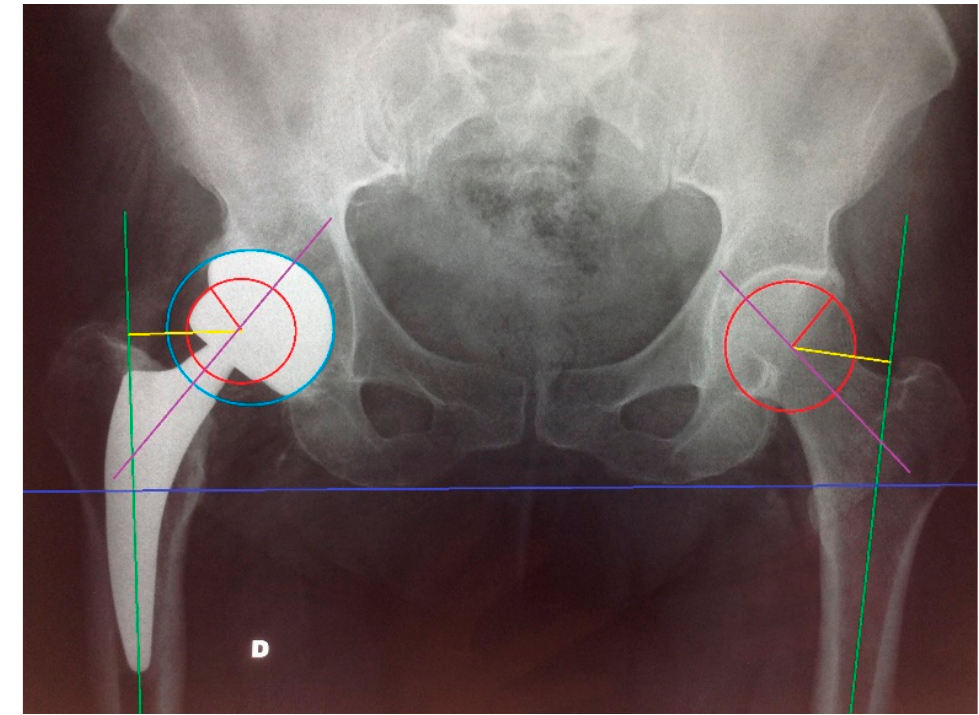
Figure 1. X-ray evaluation of joint geometry restoration.